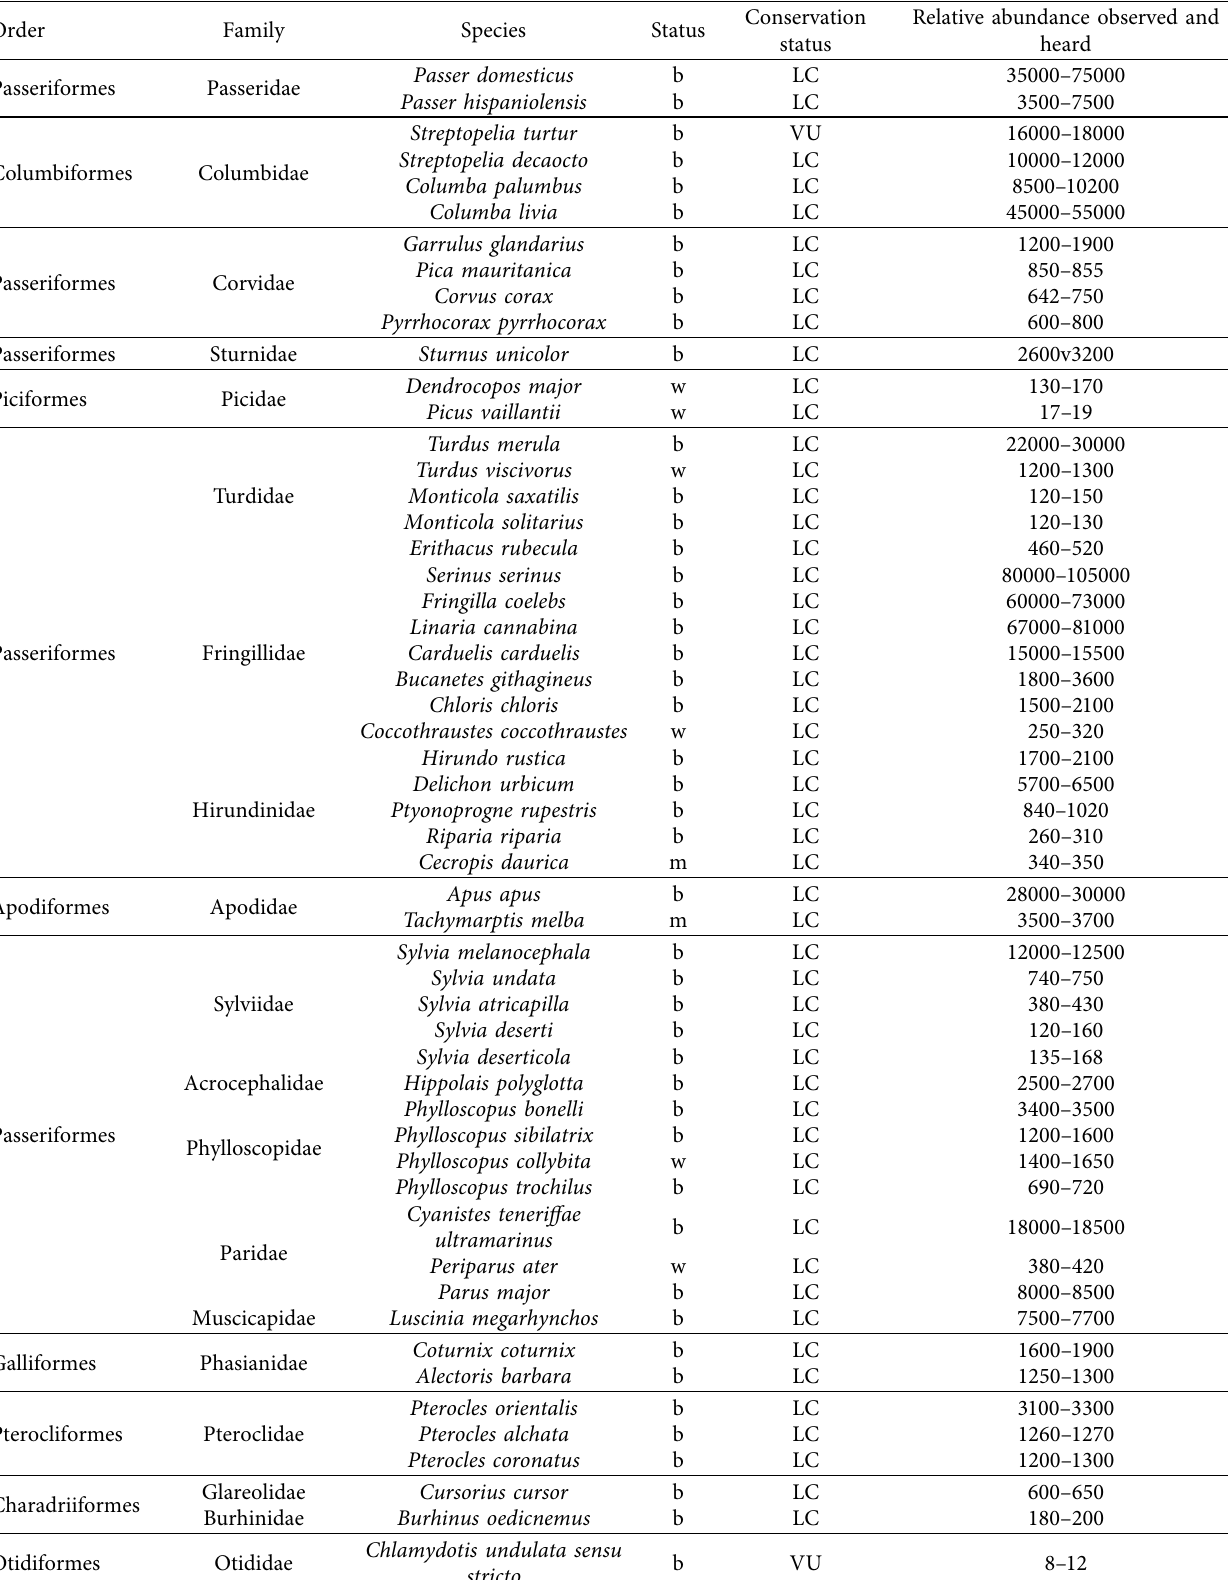
Table 3: Relative abundance, bird phenology status (b: breeding, m: migration, and w: wintering), and IUCN Red List status 2017 (E: endangered, LC: least concern, NT: near threatened, and VU: vulnerable) [34] of recorded species in Midelt